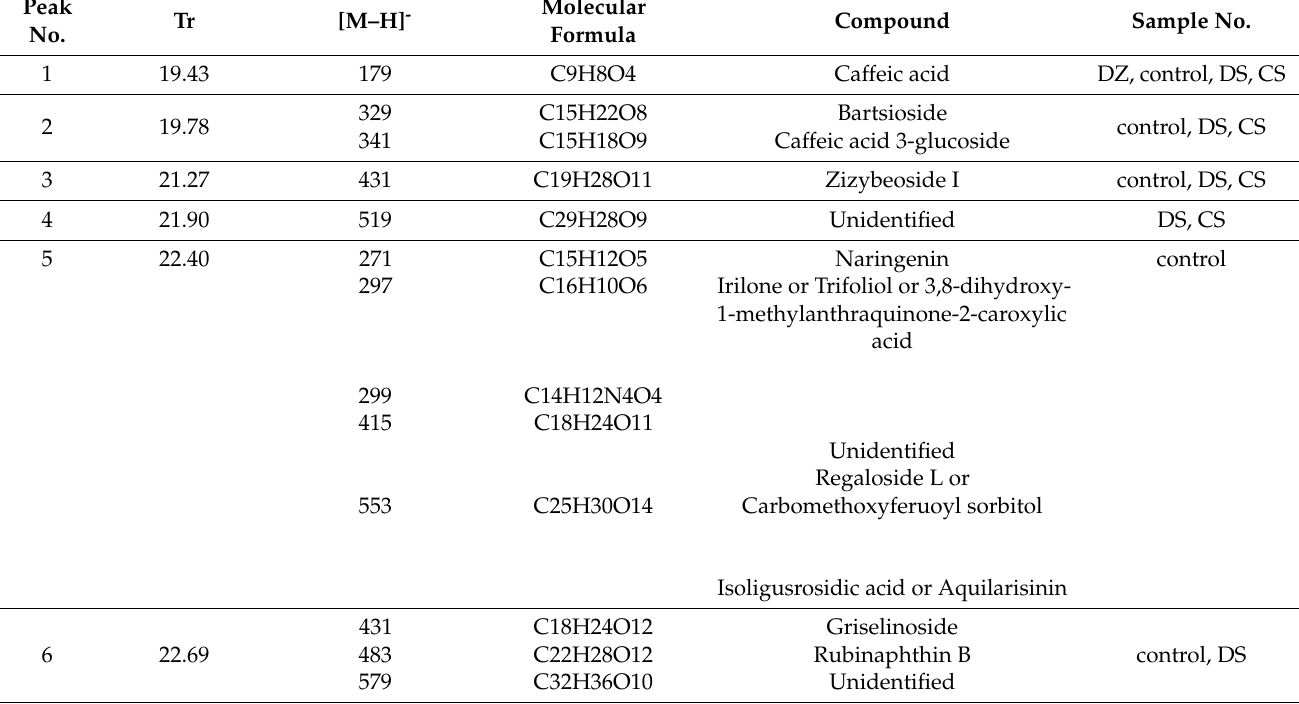
Table 6. HPLC-PDA-ESI-HRMS data on detected compounds in RgTR7 root extracts derived from various culture